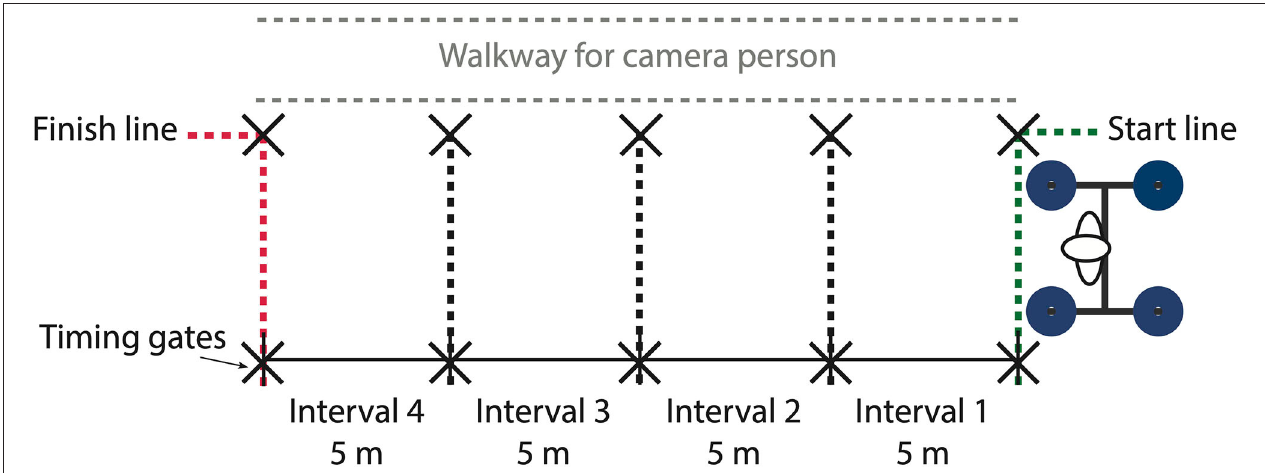
FIGURE 3 | Runway and equipment schematic.